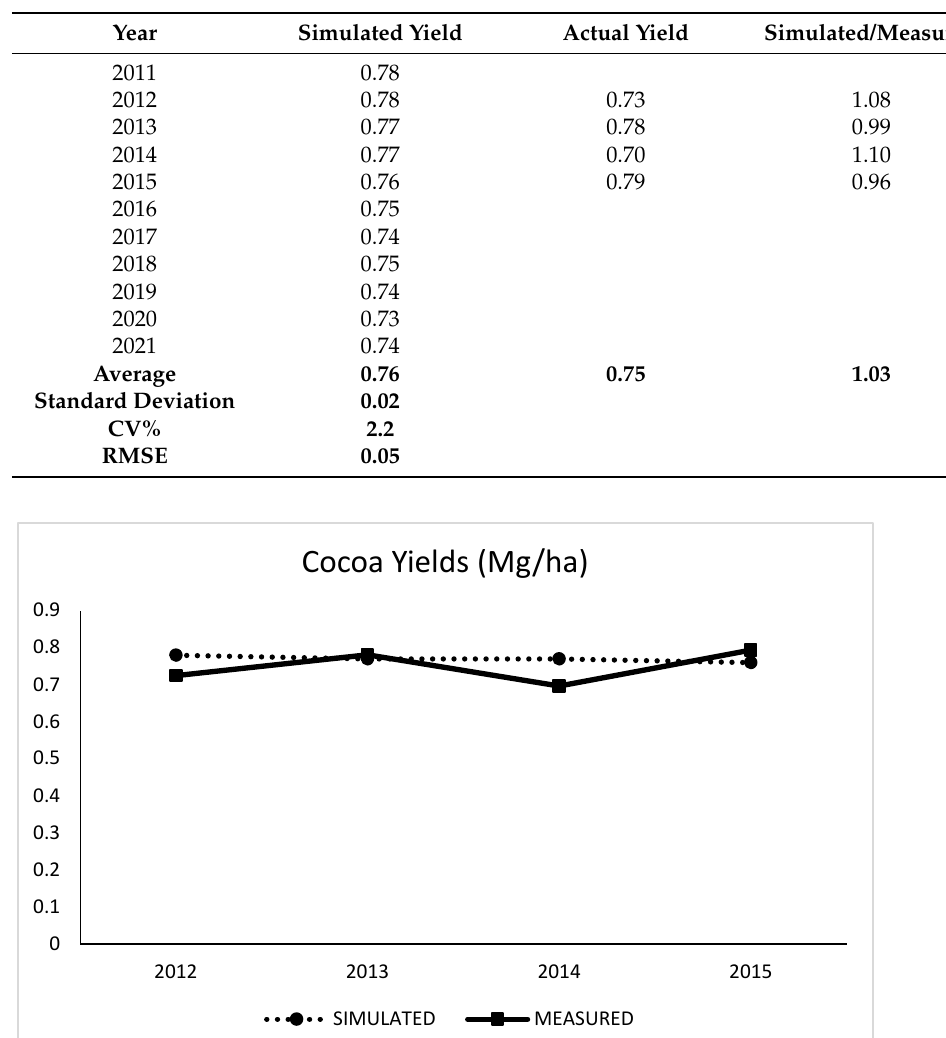
Table 8. Cocoa simulated yields in Ghana compared to measured yields in Mg/ha. For these